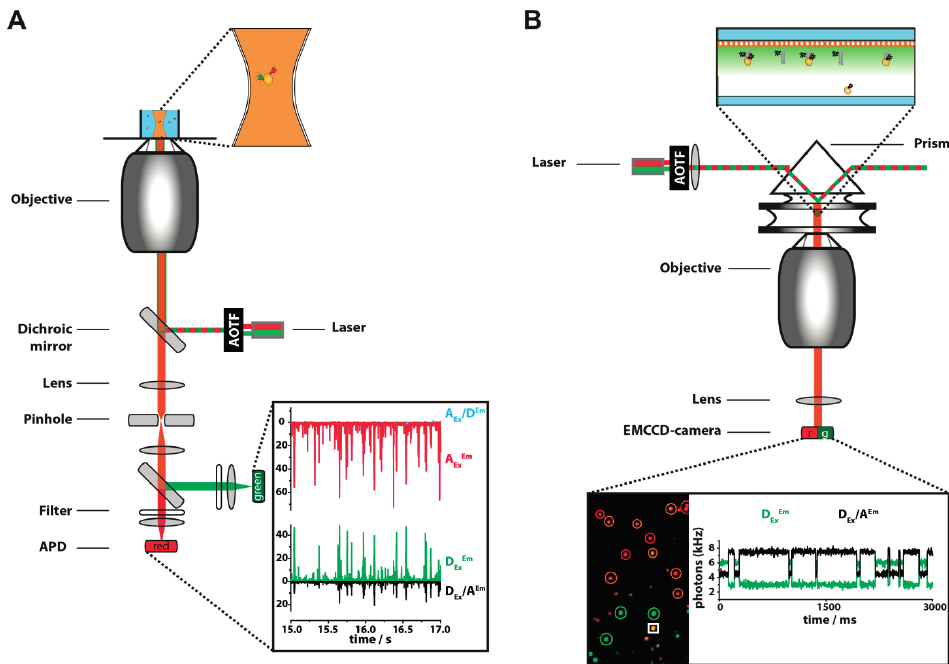
observed molecule (for details see Section 6). It moreover allows the fluorescence-aided sorting of the molecules according to defined search parameters, e.g., (i) the presence of donor and acceptor (ii) fluorescence stability of the fluorophores and (iii) the FRET efficiency of the detected molecule. Figure 5. ( A ) Two-color confocal microscopy setup: Green and red excitation lasers are combined and alternated with an acousto-optical tunable filter (AOTF) in order to excite a molecule several times with each laser during its diffusion through the focal volume. The objective focuses the light on a diffraction limited spot in solution. Only molecules that diffuse through this confocal volume are excited. In order to further confine the detection volume, the fluorescence is focused through a pinhole followed by a separation by a dichroic beam splitter onto the donor (green) and acceptor (red) detection channel by appropriate spectral filters. These photons, recorded by the avalanche photodiodes (APDs), can be assigned to four channels: acceptor excitation/donor emission (blue), acceptor excitation/acceptor emission (red), donor excitation/donor emission (green) and donor excitation/acceptor emission (FRET channel, black); ( B ) Two-color total internal fluorescence reflection microscopy. In contrast to confocal microscopy an area (approximately 50 × 50 µm 2 ) is illuminated which requires higher laser power. After combining and alternating the lasers, their beams are focused by a lens and refracted by a prism (incident angle has to be larger than 63°) onto the upper side of a flow chamber. This way an exponentially decaying evanescent field is generated and only molecules in close proximity to the quartz slide are excited. The resulting fluorescence is collected by a water objective and directed to a beam splitter, which separates the fluorescence according to their wavelength. A lens-mirror system projects the donor and the acceptor fluorescence spatially shifted onto an EMCCD camera chip. By software aided superposition of both areas, subpopulations can be identified (green circles: donor only, red circles: acceptor only, orange circles: donor and acceptor) and the fluorescence signal of the molecules can be monitored over time (signal of the molecule in the white